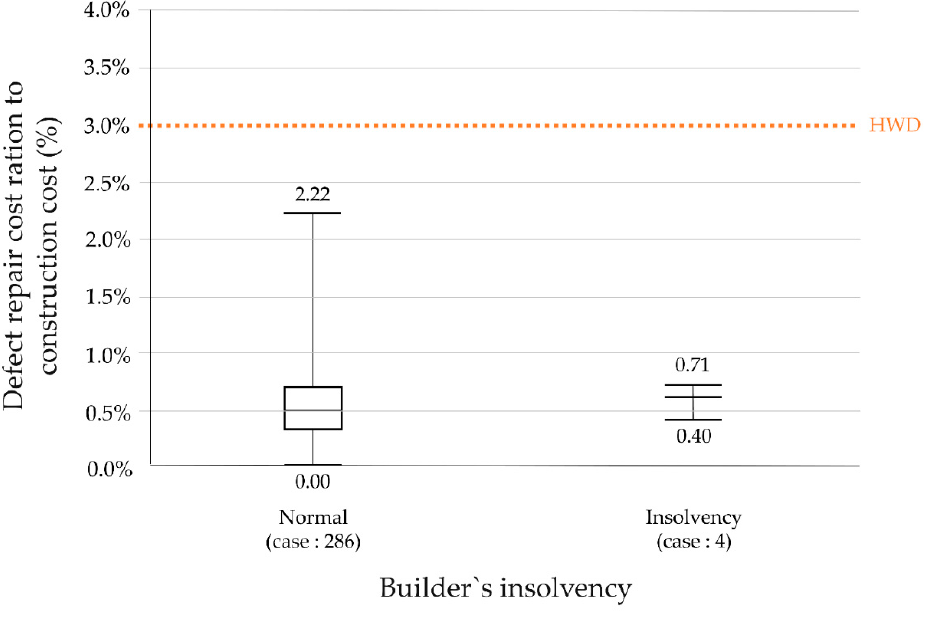
Figure 11. Comparison of builder`s insolvency.